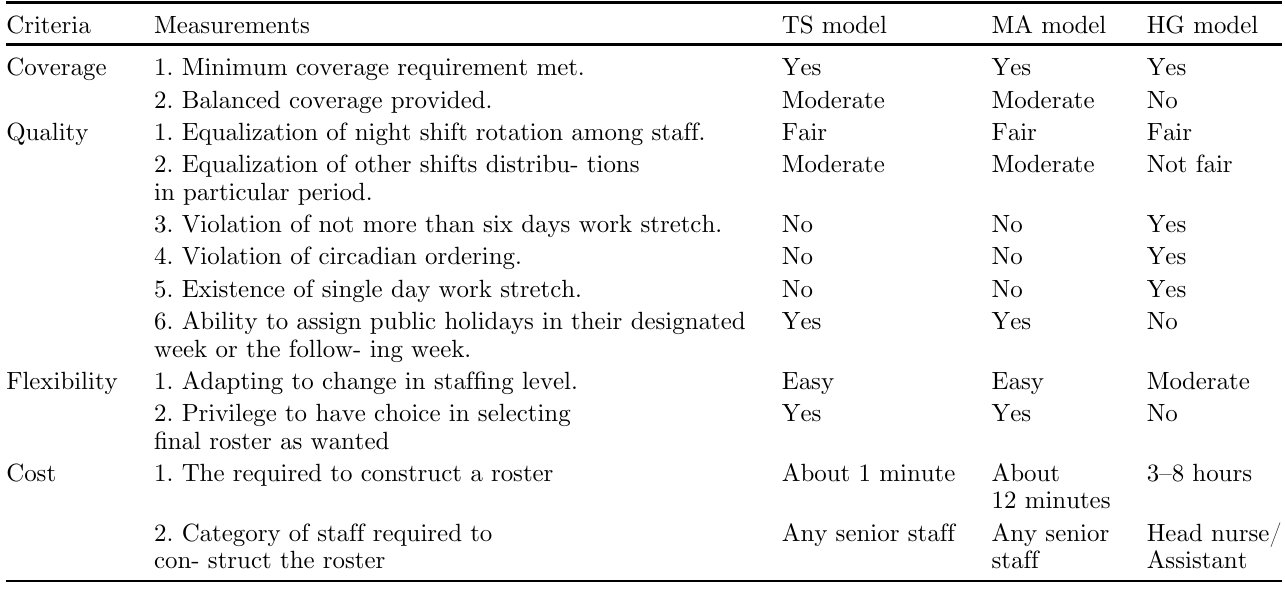
Table 3. Results based on different criteria for models comparison (TS model = our approach, MA model = Memetic Algorithm model by Ramli (2004) and HG model = manual